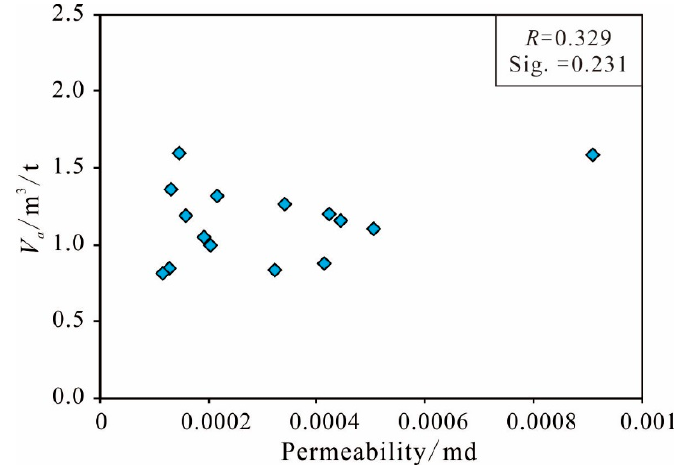
Figure 20. No obvious relationship between V a and permeability.